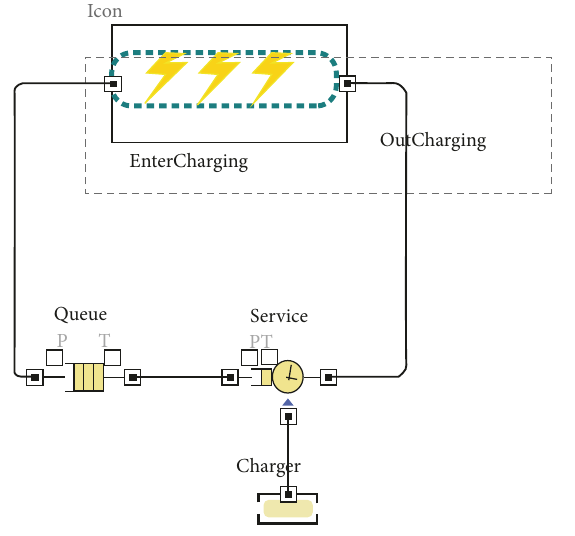
Figure 12: Charging active